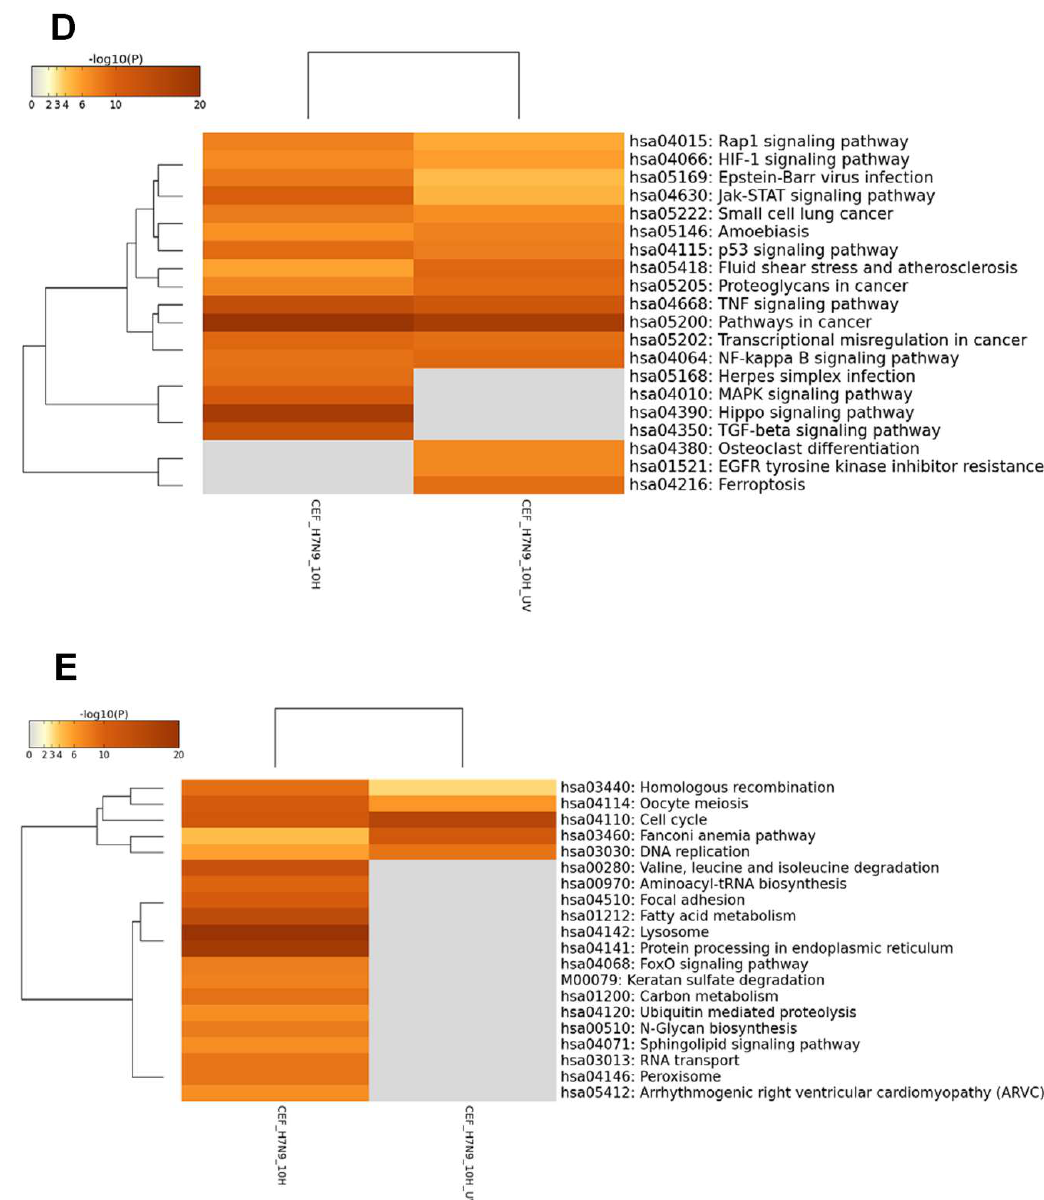
Figure 3. Di ff erentially expressed genes (DEGs) in CEF cells infected with H7N9 virus. ( A ) Principal component analysis of the gene expression changes at 2 and 10 hours post-infection (hpi) ( B ) Number of up- and down-regulated genes in untreated and ultra-violet (UV)-treated virus infections. ( C ) Pairwise analysis of the DEGs at 10 hpi showing (i) up- and (ii) down-regulated genes in untreated and UV-treated virus infections. ( D ) Functional annotation of up-regulated DEGs. ( E ) Functional annotation of down-regulated DEGs.